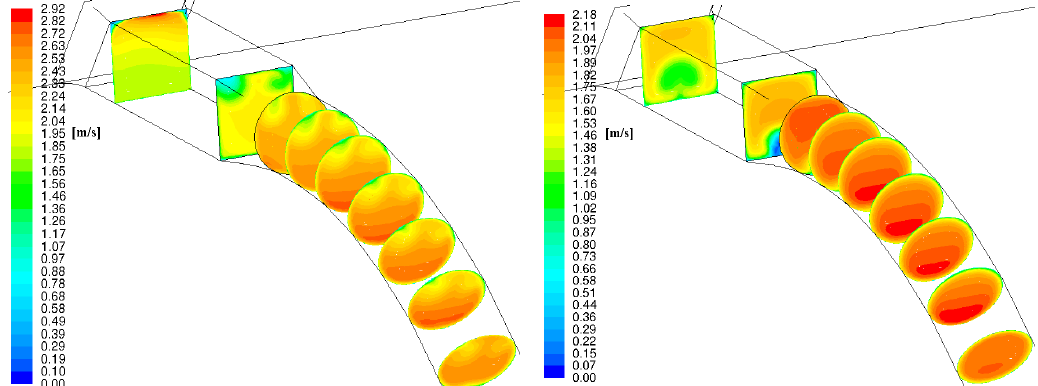
Figure 6. The water velocity contours in the penstock inlet part with first elbow for discharge of Q = 35 m 3 /s in turbine regime ( left view ) and for discharge of Q = 28 m 3 /s in pump regime ( right view ) .